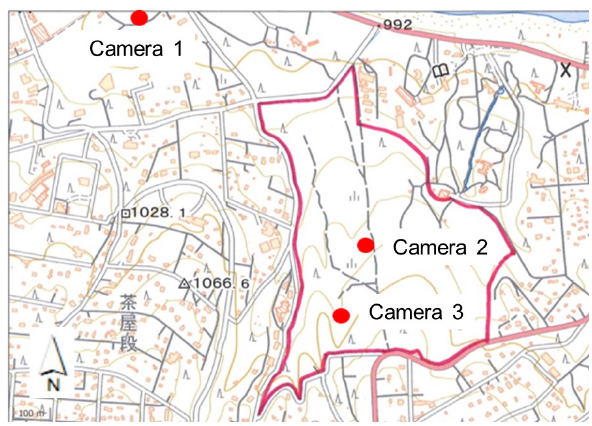
Figure 3 . Location of shooter (red circle), beater (blue circle) and entrance points for beater (yellow circle). Red line shows the study